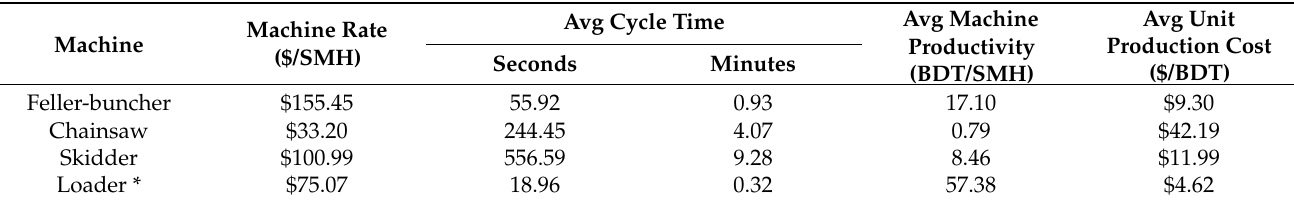
Table 5. Average individual machine rates, cycle times, productivity, and unit production costs, if hauling to Crescent Mills. Individual machines only, not system